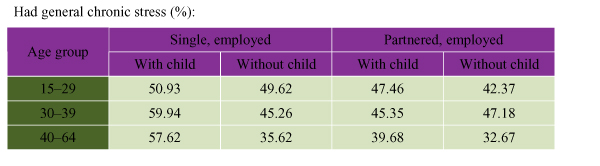
Percentage of Women Reporting High Chronic Stress by Age Group, With and Without Children. Source: Statistics Canada, National Population Health Survey, 1994–1995.